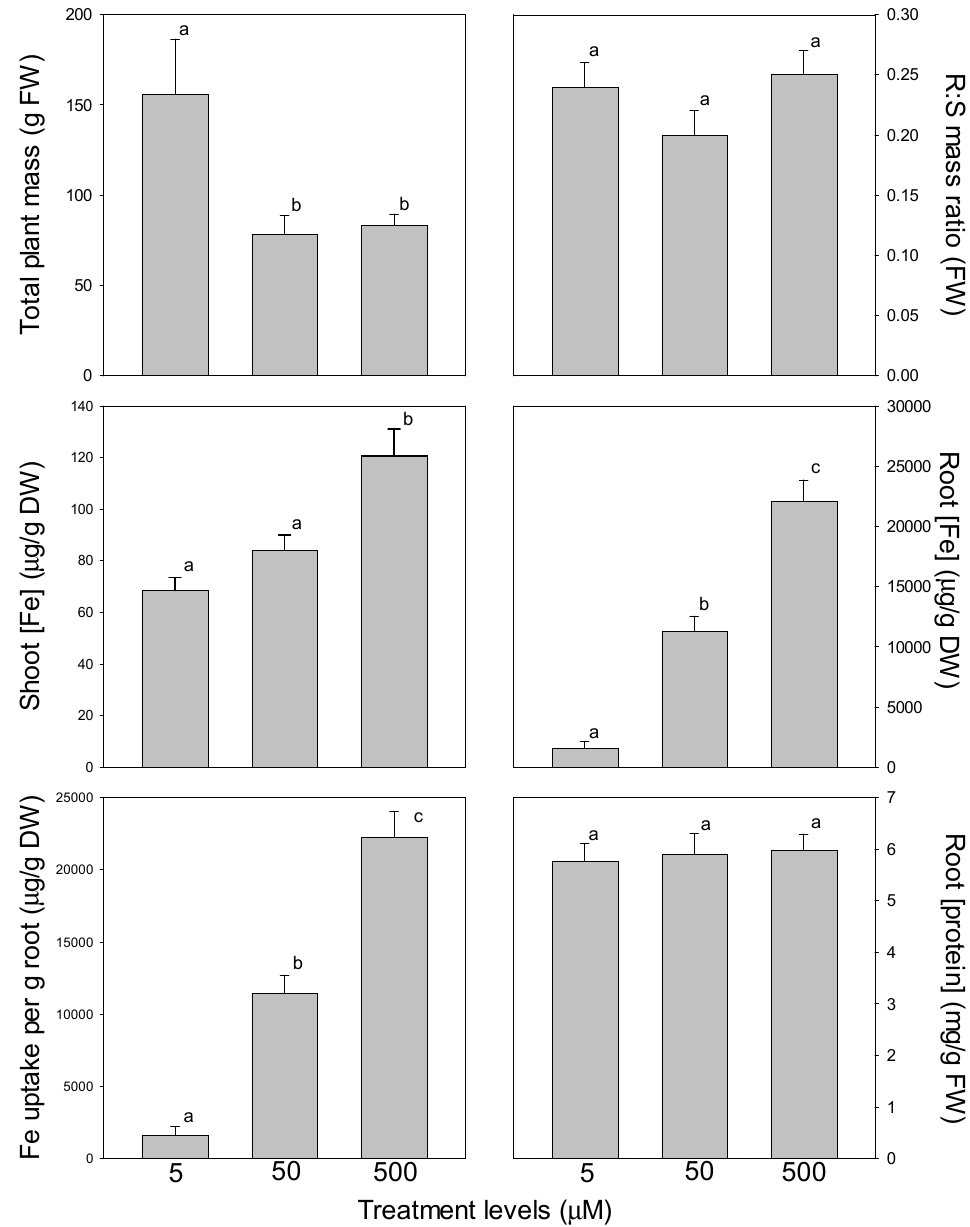
Figure 3. Effects of variation in Fe availability in tomato on total plant fresh mass (FW), root-to-shoot fresh-mass ratio, shoot and root Fe concentration (dry mass basis, DW), Fe uptake per g root; (= total plant Fe per g root, dry mass basis), and root protein concentration (fresh mass basis). Results are means + 1 SE; letters above bars indicate comparisons among treatments (different letters indicate significant differences at p < 0.05).